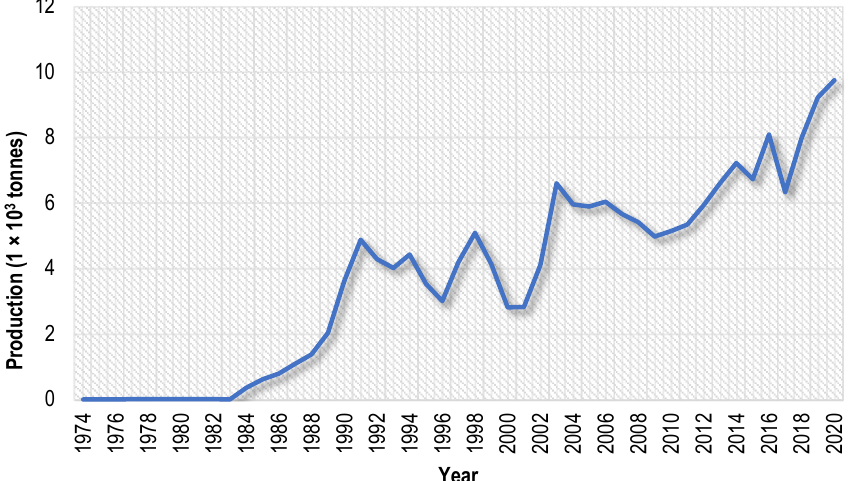
Figure 1. Aquaculture production in South Africa (1974–2020). Source: FAO [2] and World Bank [8].